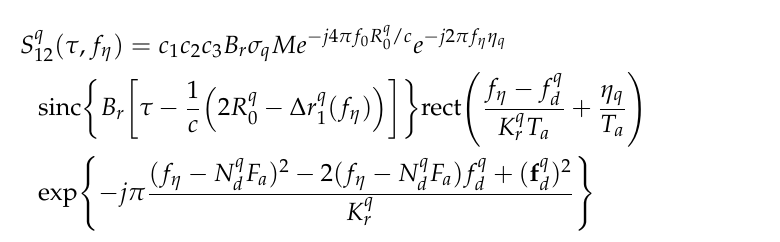
( τ , f η ) , Doppler spectrum after 12